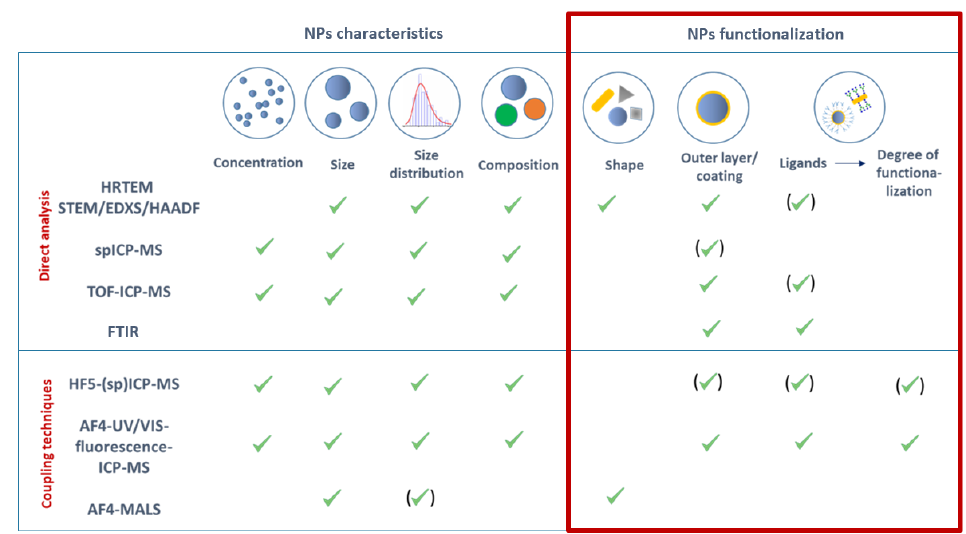
Figure 1. Overview of analytical techniques potentially applicable for the characterization of gold nanorods conjugated with synthetic glycopolymers.